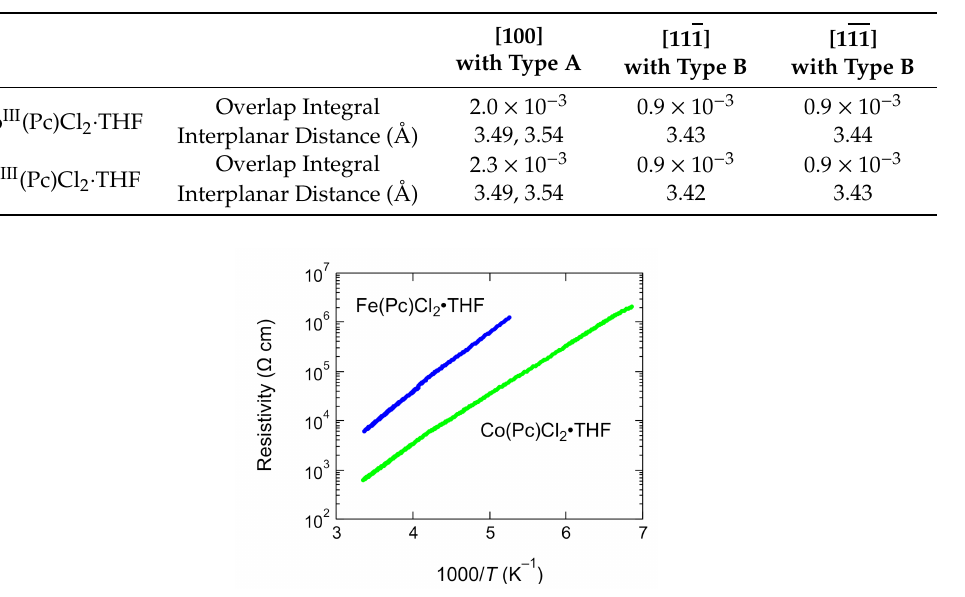
Figure 5. Crystal structure of Co III (Pc)Cl 2 · THF: ( a ) view perpendicular to Pc plane, ( b ) molecular arrangement along the a -axis, and ( c ) molecular arrangement along [111] and [111] directions. Tetrahydrofuran (THF) molecules have been omitted for clarity. Table 2. Overlap integrals between HOMOs of adjacent Pcs in M III (Pc)Cl 2 · THF.